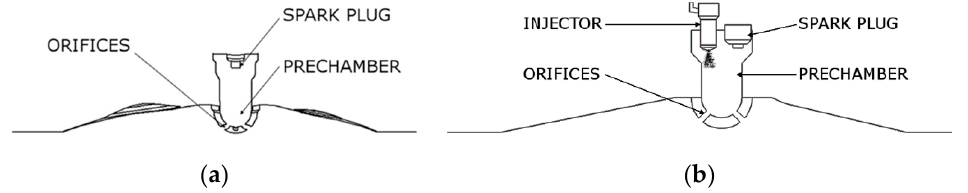
Figure 1. ( a ) Conceptual scheme of passive prechamber; ( b ) conceptual scheme of active prechamber with dedicated injector fueling